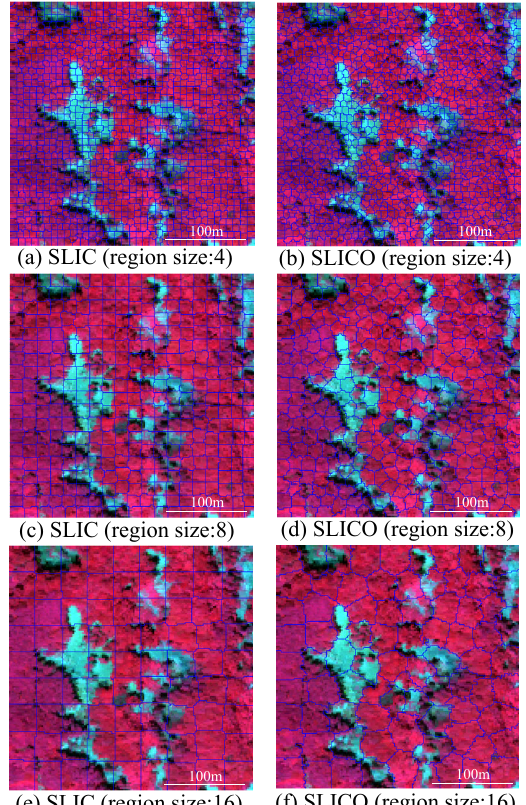
Figure 4. Comparison of segmentation in area 1